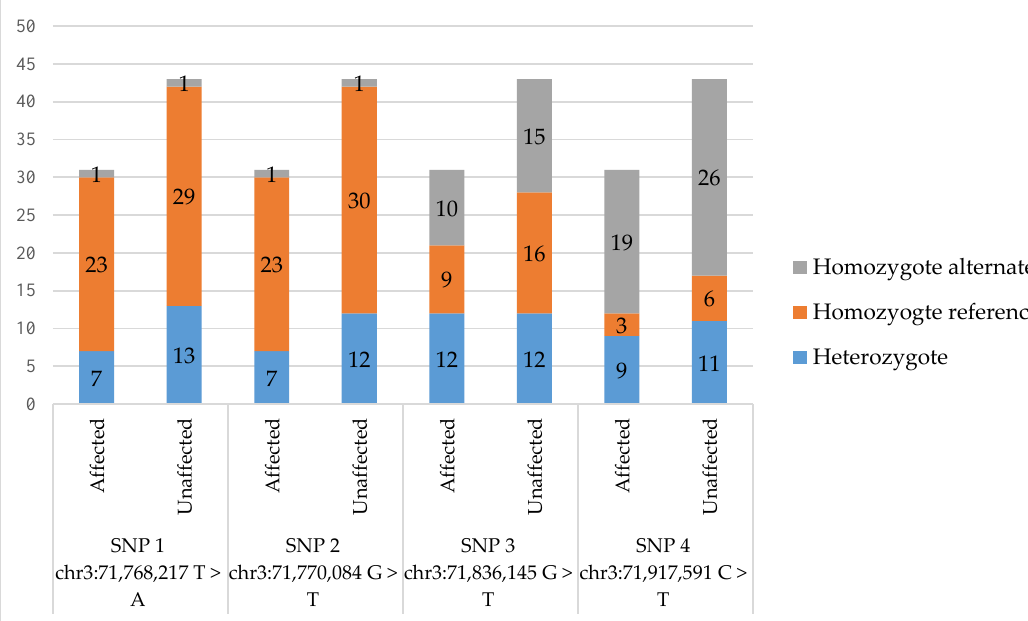
Figure 1. Graphical representation of the genotype distribution of all genotyped horses. The number of horses is denoted in each section of the bar graph. Single nucleotide polymorphism (SNP)positions are from EquCab2.0. No SNP achieved a significant ( P < 0.05) association with the equine neuroaxonal